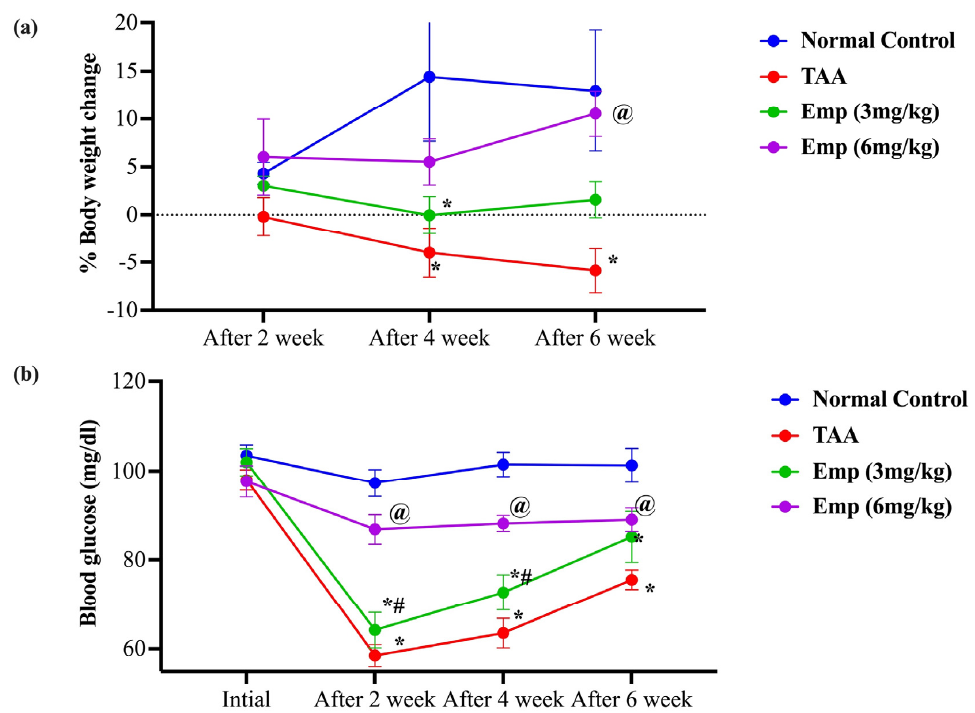
Figure 1. ( a ) Effect of empagliflozin on the percentage change in body weight in thioacetamide- intoxicated rats. ( b ) Effect of empagliflozin on blood glucose in thioacetamide-intoxicated rats. Data are presented as mean ± SE. * vs. normal control group, @ vs. TAA group, # vs. Emp (3 mg/kg) at p < 0.05.